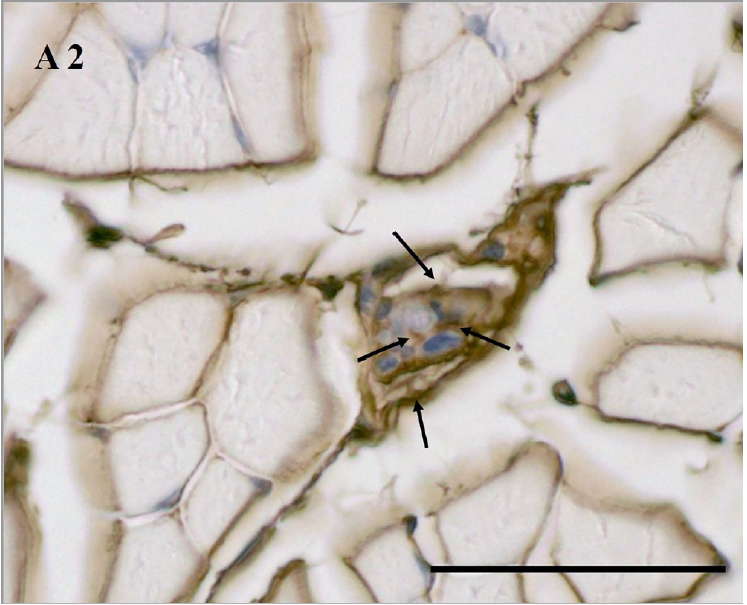
Figure A2. HA is present in the MS capsule and round intrafusal fibres. Scale bar: 50 μ m.